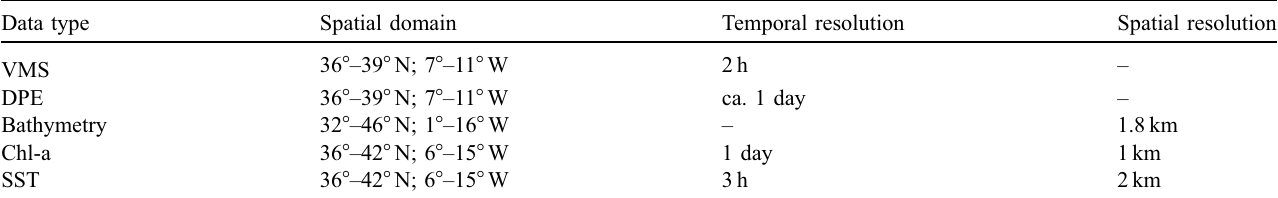
Table 1. Description of